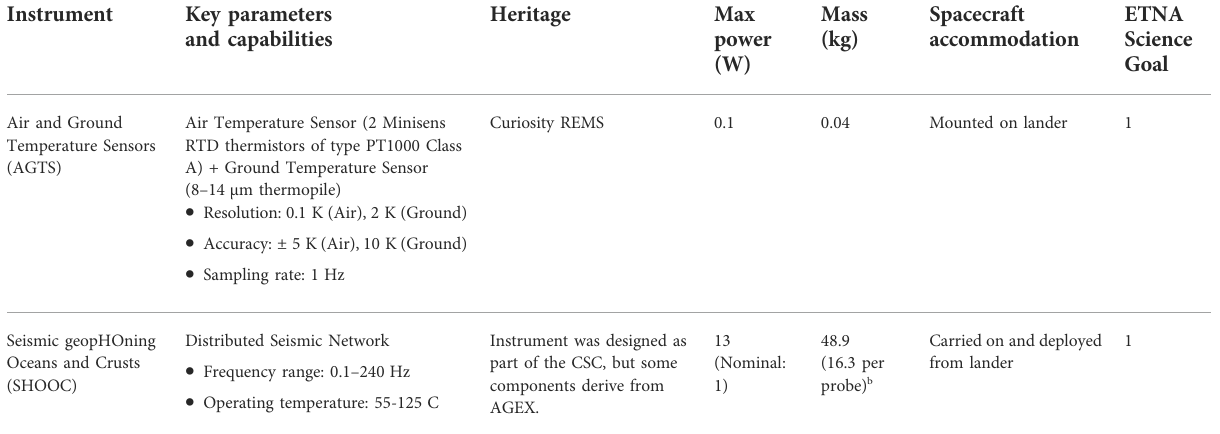
TABLE 2 ( Continued ) ETNA science instrument suite. Power and mass estimates are from heritage